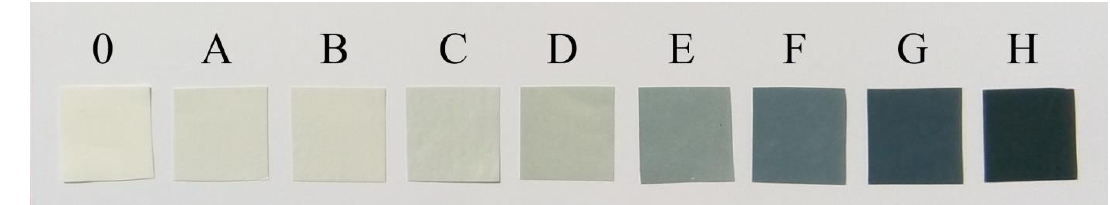
Figure 2. Images of membrane pure PAN membrane (membrane 0) and rGO/PAN composite membranes (membranes A-H).